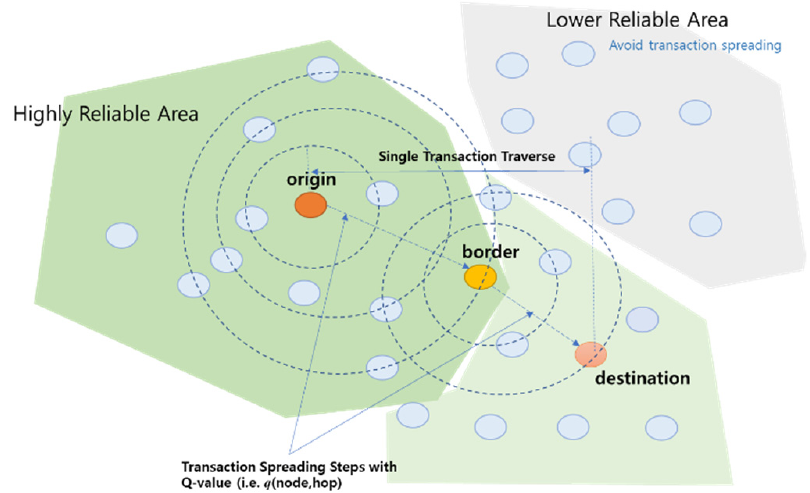
Figure 2. Transaction Spreading over Reliable Area.